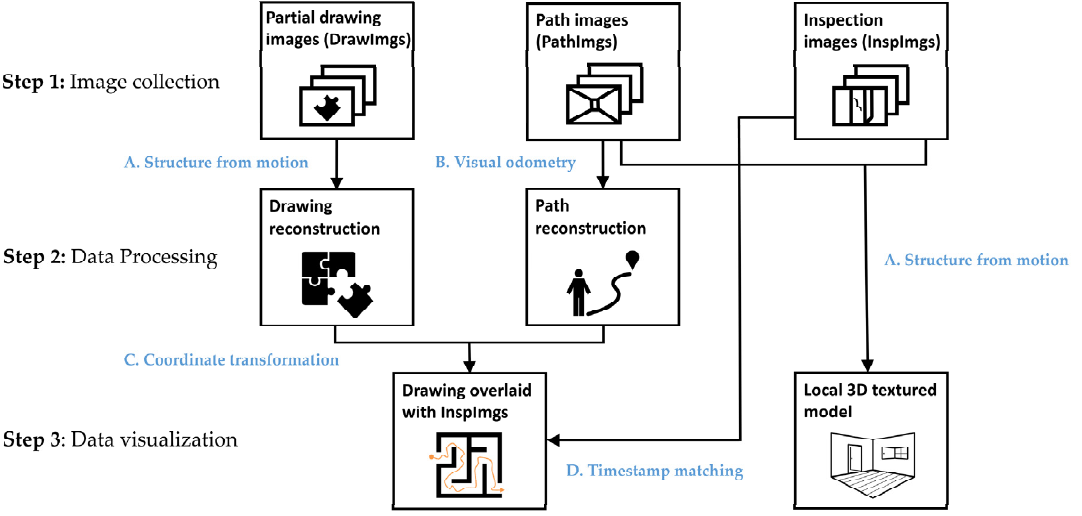
Figure 1. Overview of the technical approach.